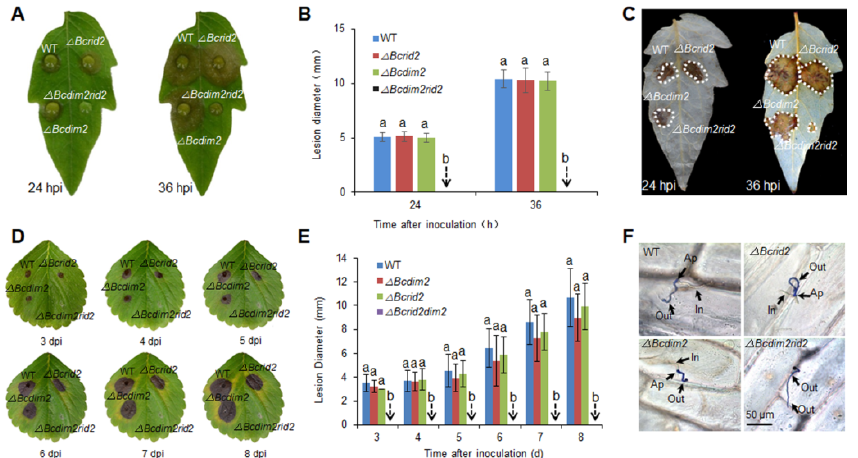
Figure 4. Verification of the synergistic effect of Bcdim2 and Bcrid2 on leaf hosts. ( A ) Disease symptoms on detached tomato leaves. ( B ) Lesion diameters on detached tomato leaves. ( C ) Detection of ROS accumulation around the infectious sites of tomato leaves after inoculation. The infected tomato leaves were stained by DAB after 24 and 36 h of inoculation. ( D ) Disease symptoms on detached strawberry leaves. ( E ) Lesion diameters on detached strawberry leaves. ( F ) Onion epidermis penetration assay. The onion epidermises were stained by cotton blue after 16 h of inoculation. In: the hyphae infected into the onion epidermis cells (brown color); Out: the hyphae outside the onion epidermis cells (blue color); Ap: appressoria. Vertical bars represent standard errors of the means. Columns with different letters indicate significant differences ( p < 0.05).